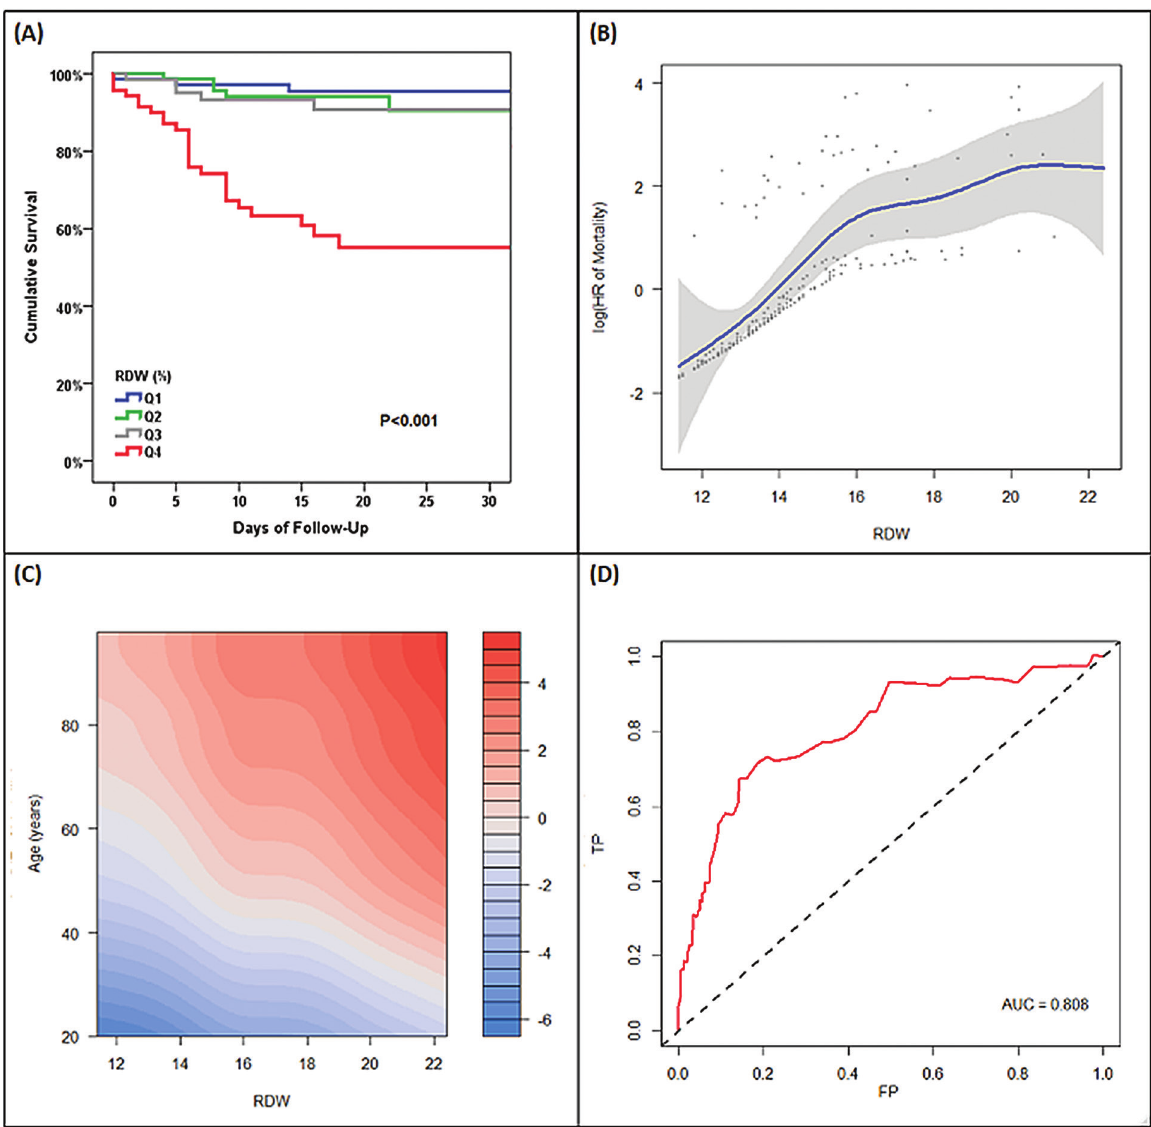
Figure 1. Association Between Continuous RDW and Mortality (A) unadjusted Kaplan-Meier curves, (B) unadjusted Cox regression model with RDW modelled using a penalized smoothed spline, (C) penalized-smoothed spline modelled age and RDW (color code represents log (Hazard Ratio) of mortality). Red demonstrates higher hazards of mortality and blue demonstrates lower hazards of mortality. This is modelled by age and RDW showing that 2% increase in RDW is equivalent to 10 year age increase with respect to mortality (D) Receiver Operating Characteristic curve for RDW to predict 30-day mortality (using Kaplan-Meier method) Abbreviations: HR=hazard ratio; RDW=red cell distribution width; TP = true positive rate; FP = false positive rate; AUC=area under the